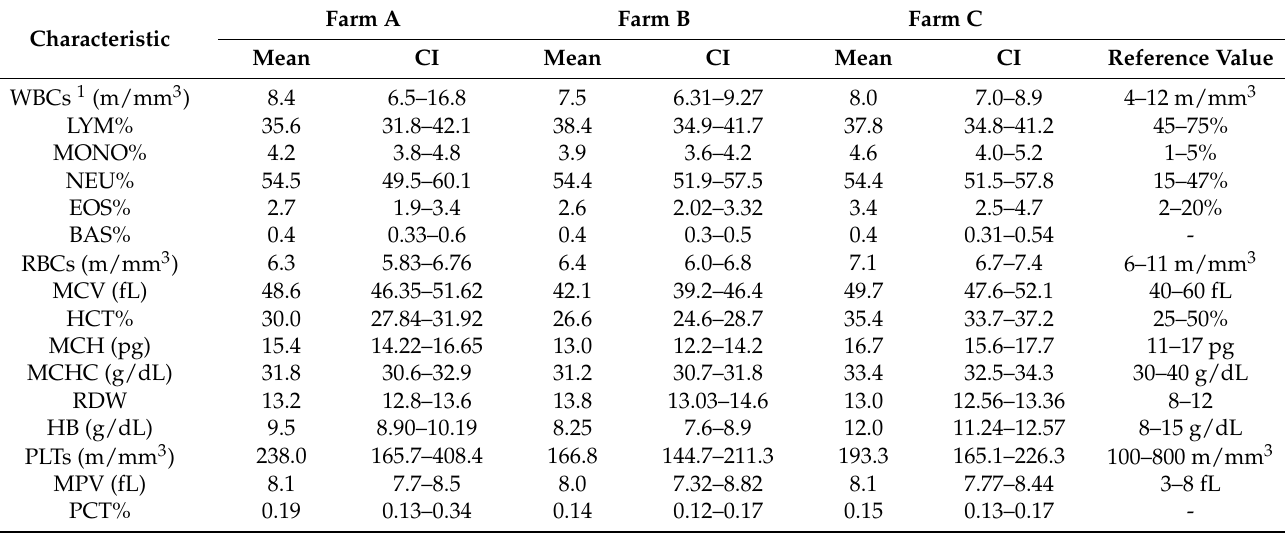
Table 3. Blood parameters in lactating cows: mean and confidence intervals